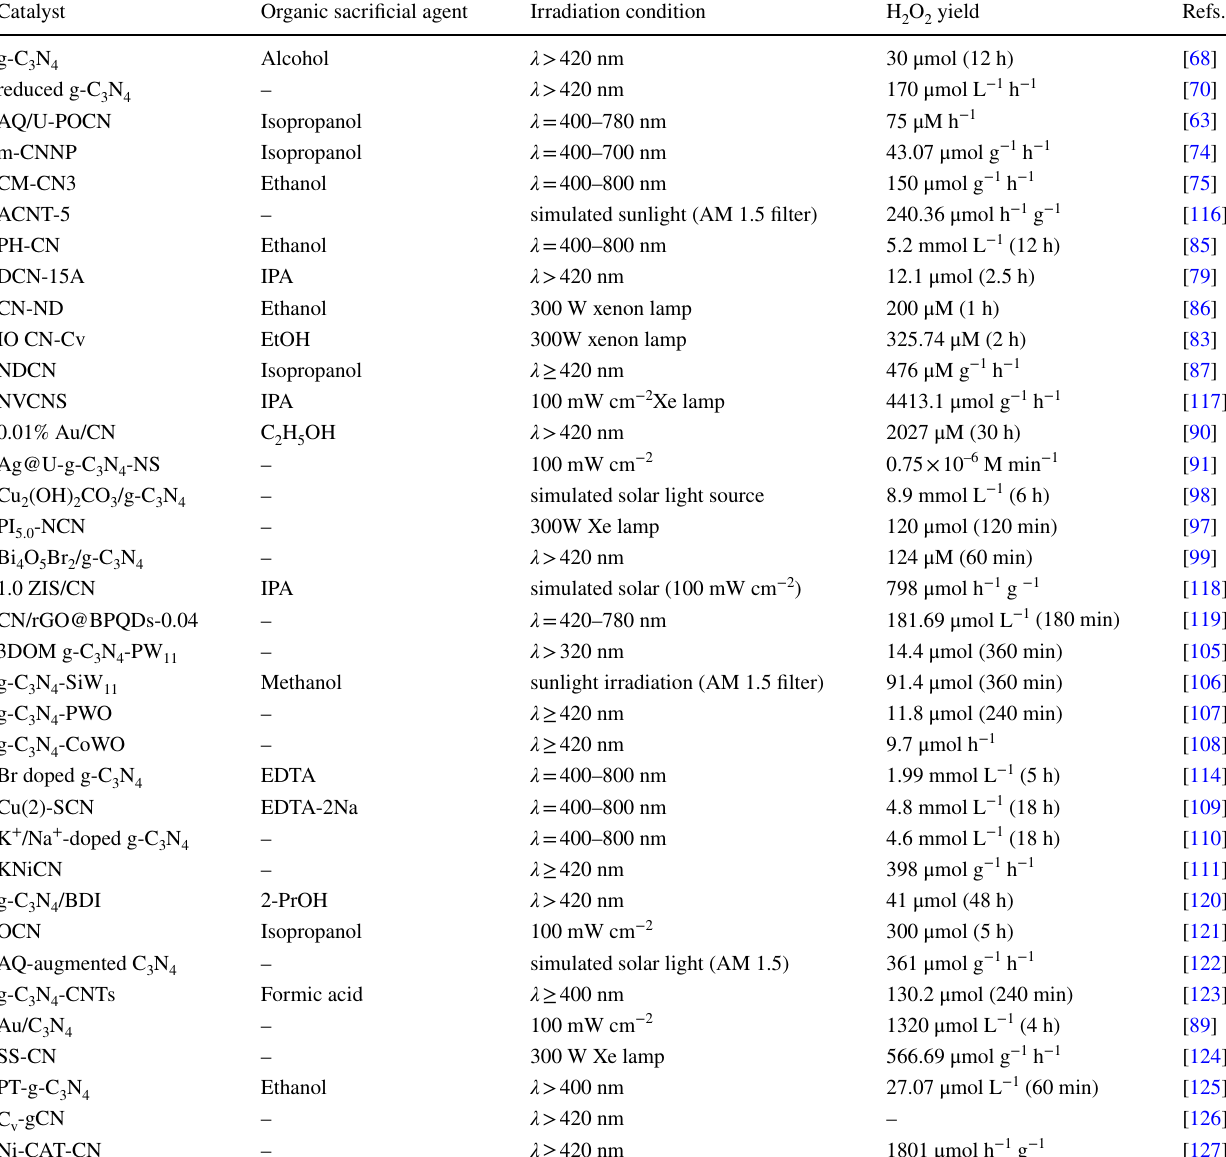
Table 1 Summary of the g-C 3 N 4 photocatalysts for the H 2 O 2 production